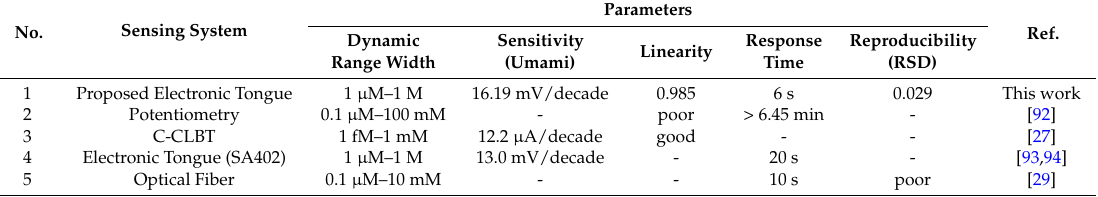
Table 4. Summary of sensing performance for the different sensing